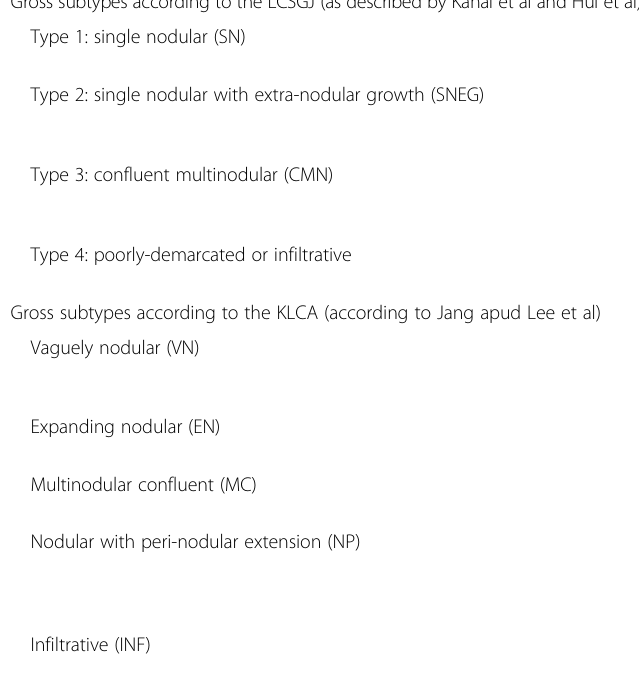
nodule with clear